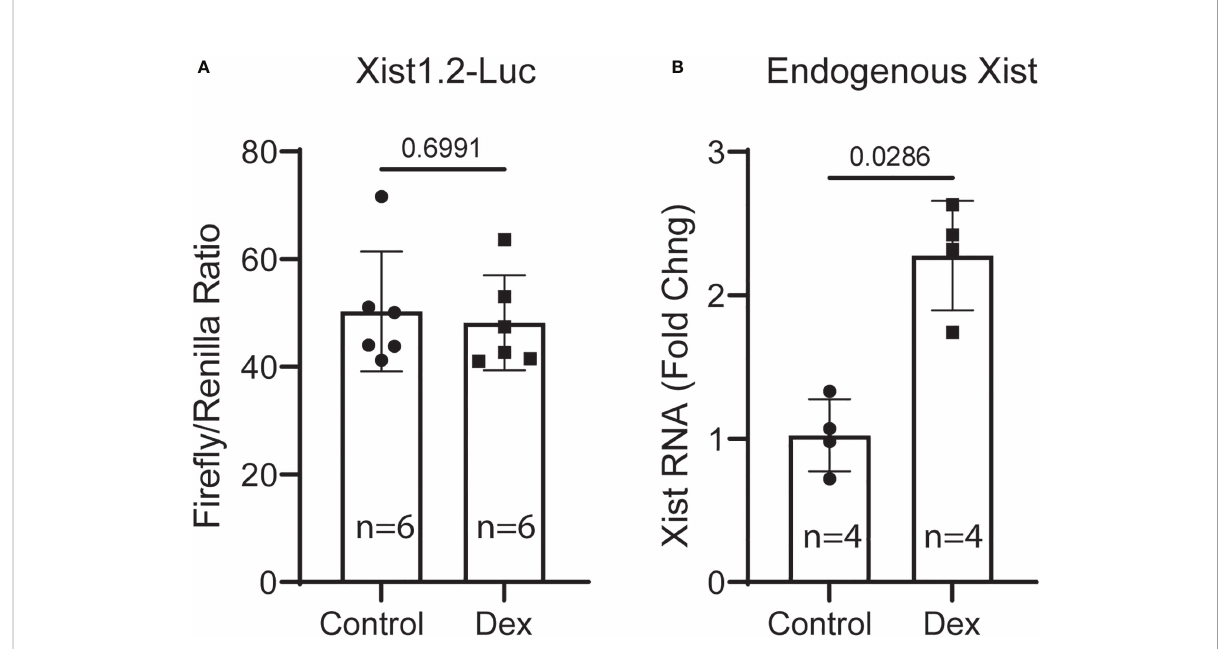
FIGURE 7 Transient transfection and luciferase-reporter assays. (A) MSCs were transfected with Xist1.2-Luc promoter reporter construct for 18 hr and then treated without or with 10 nM Dex for 6 hr before harvesting for luciferase activity assay. (B) qRT-PCR analysis of RNA samples retrieved from cell lysates (A) showing induction of endogenous Xist RNA by Dex in transfected cells. Experiment was performed 3 times with similar results. Shown is the result from one representative experiment performed in hextuple. RNA was retrieved from a pool of lysates (6 wells in each group) and PCR reactions were performed in quadruple. t -test, p values are